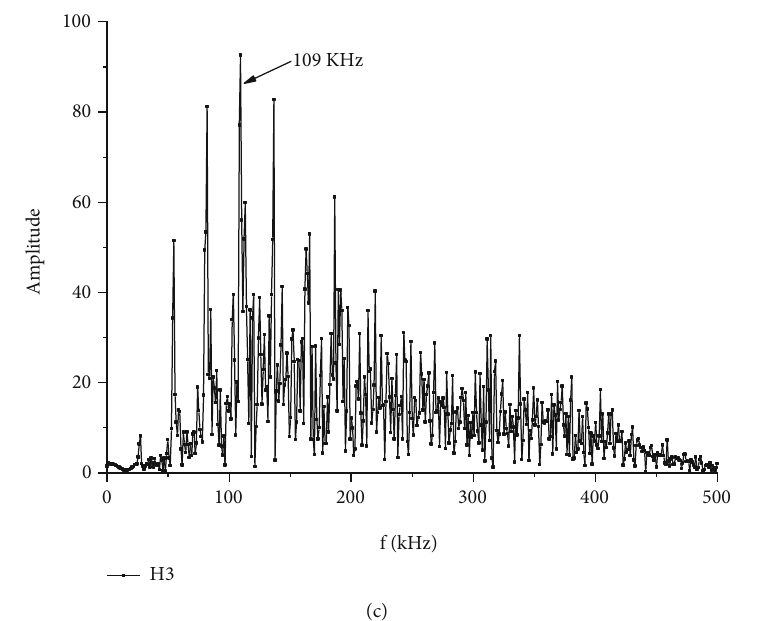
Figure 6: Waveform spectrogram of the maximum cutting force of di ff erent types of